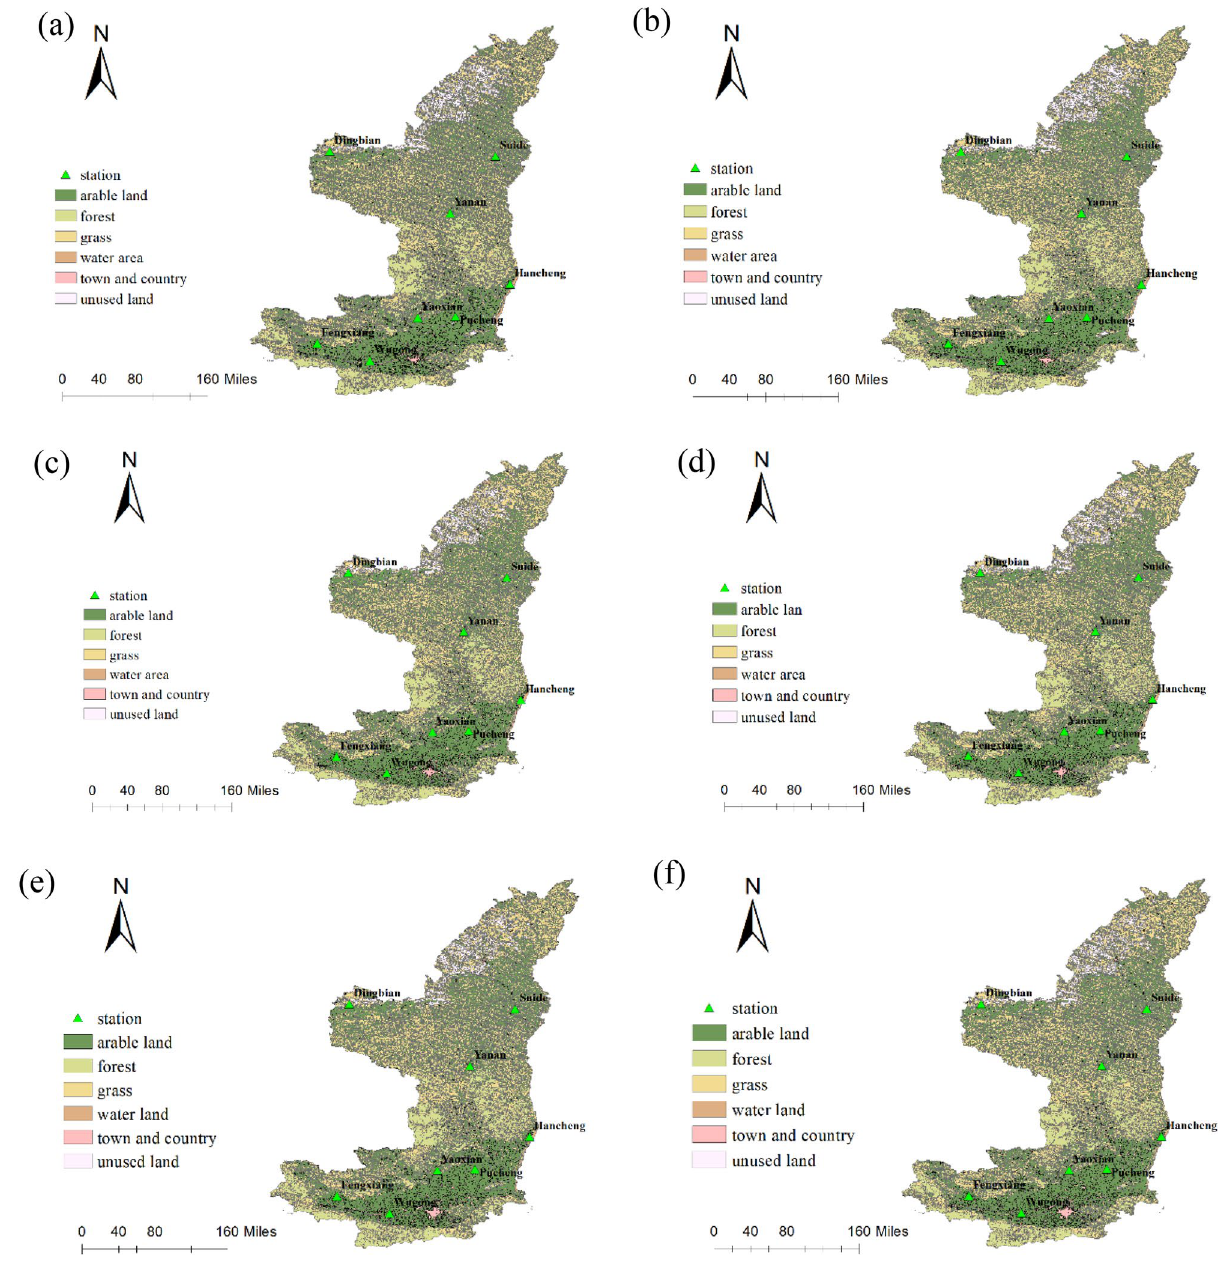
Figure 2. Land use of study area in 1980 ( a ), 1990 ( b ), 1995 ( c ), 2000 ( d ), 2005 ( e ), 2010 ( f ) (Arcmap10.8 https:// www. resdc. cn/).